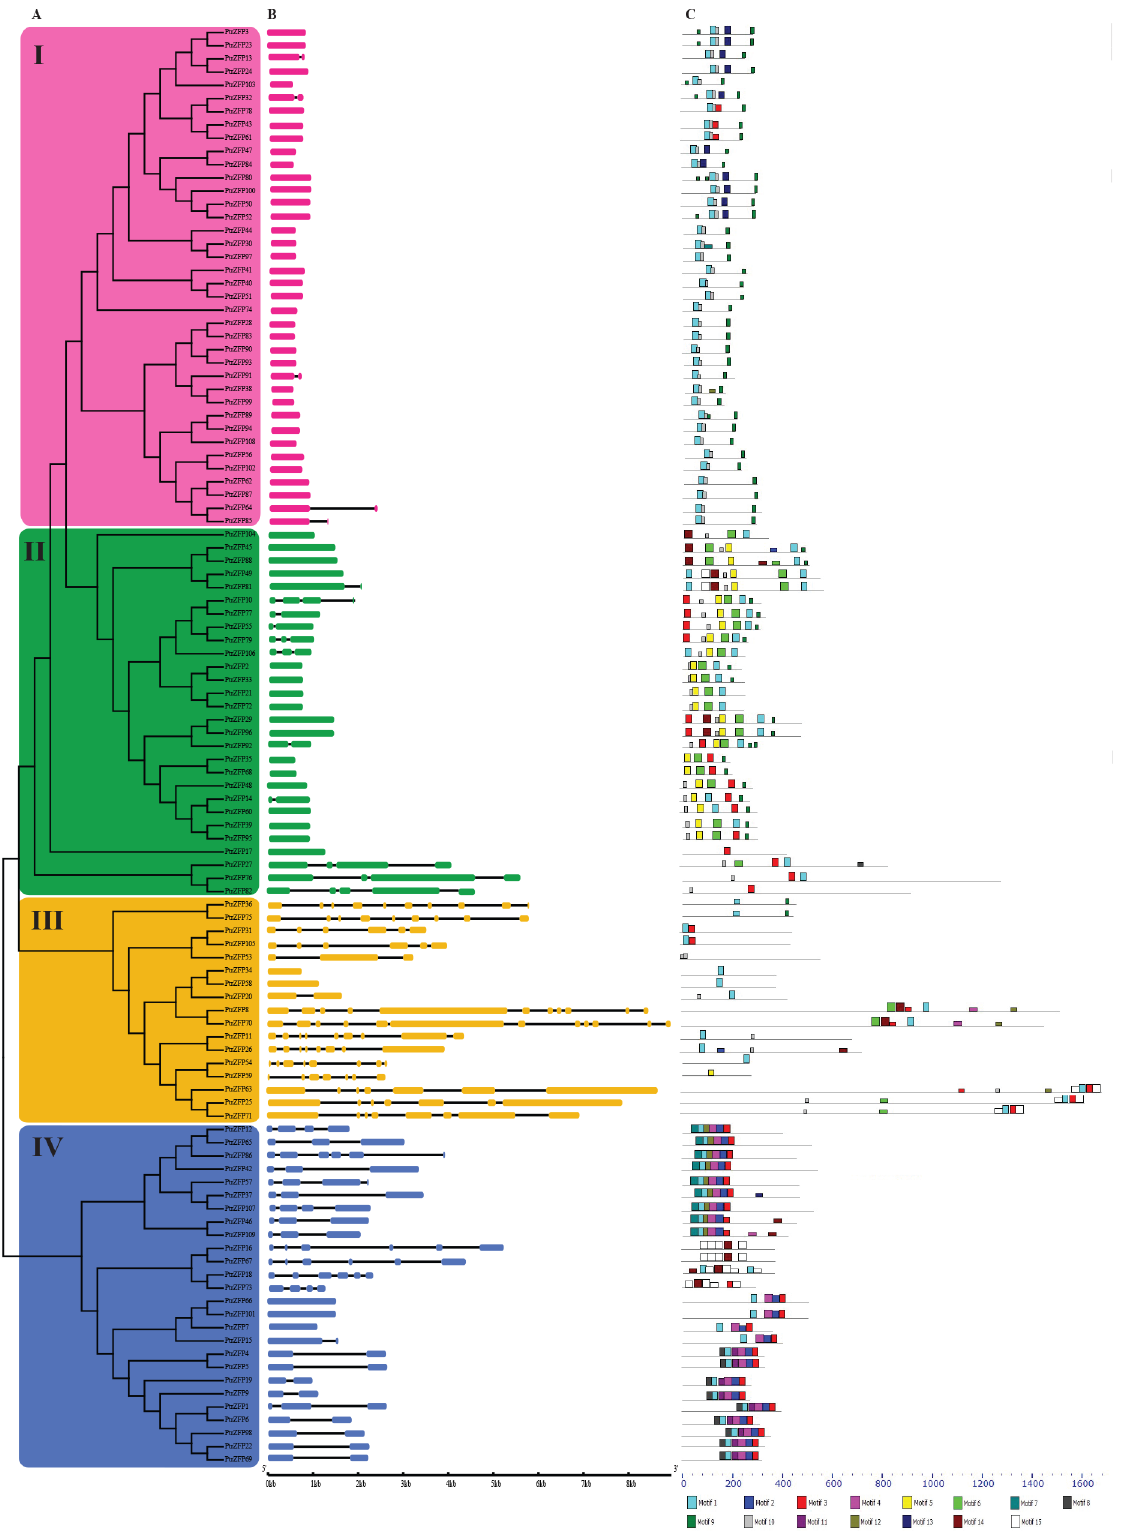
Fig 1. Phylogenetic relationships, gene structure and motif compositions of Populus C2HC2-ZF genes. A. Multiple alignment of 109 full-length amino acid sequences of Populus C2HC2-ZF genes, executed by ClustalX 1.83. The phylogenetic tree was constructed using MEGA 5.0 and the neighbor-joining